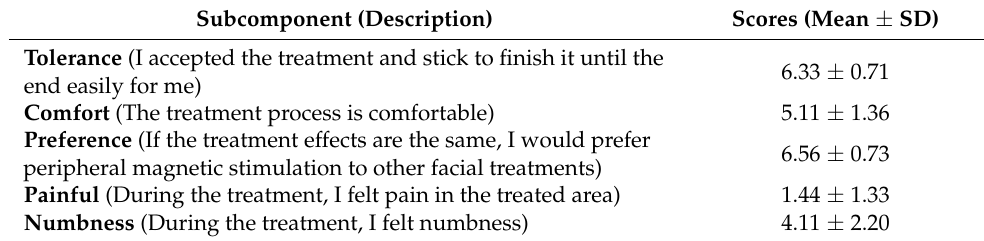
Table 5. Results of the